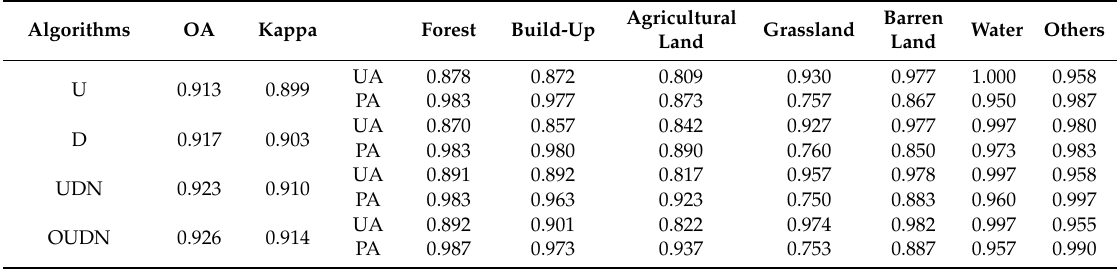
Table 5. The classification accuracies of the U, D, UDN, and OUDN algorithms based on the Spe-Index, including the accuracies (UA and PA) of every class, OA and Kappa. Algorithms